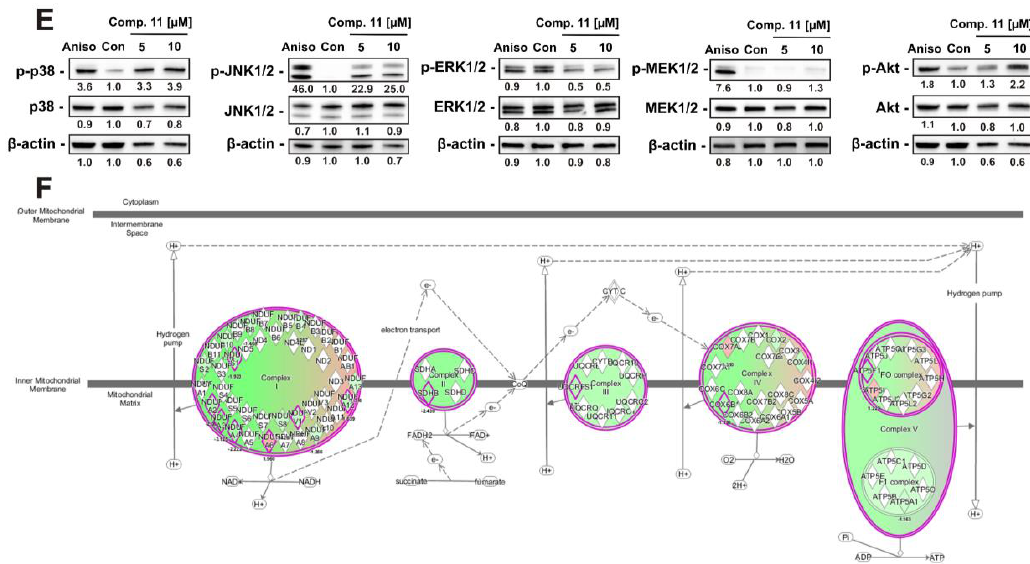
Figure 4. Proteomic and bioinformatical analysis of the e ff ect of compounds 11 in human prostate cancer cells. 22Rv1 cells were treated with 5 µ M of compound 11 for 48 h and the changes in proteome were analyzed with by LC-MS / MS. Bioinformatical analysis of the proteomics data was performed using Ingenuity Pathway Analysis (IPA) and z -score algorithm. Biological functions expected to be activated ( z -score > 0, red area) or suppressed ( z -score < 0, green area) are presented. ( A ) GO analysis. ( B ) Top predicted upstream target. p -value of overlap is indicated on the graph as * ( p < 0.05). ( C ) Top predicted canonical pathways. ( D ) Hypothetical protein interaction networks constructed using IPA software. Relationships between proteins regulated upon exposure with compound 11, and proteins predicted to be involved in interactions, as well as relevant signaling pathways are presented. Red nodes represent up-regulated proteins, green nodes represent down-regulated proteins. Several kinases predicted by IPA software to be affected under the treatment are marked with red target sign. ( E ) Western blotting analysis of the kinases following 2 h treatment with compound 11. β -actin was used as a loading control. Detailed information of Figure 4E (Western blotting) can be found at Figure S2. ( F ) Representative schema of oxidative phosphorylation signaling built by IPA software. The molecule discovered by proteomics to be a ff ected in cells under 22Rv1 treatment are indicated by color. 2.8. Mitochondria Are a Primary Target of Quinone-Glucose Conjugates 7 and 11 in Prostate Cancer